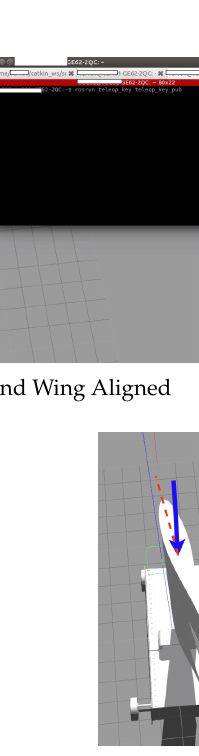
These tests verify if the wing sail turns correctly given a change in the flap angle.